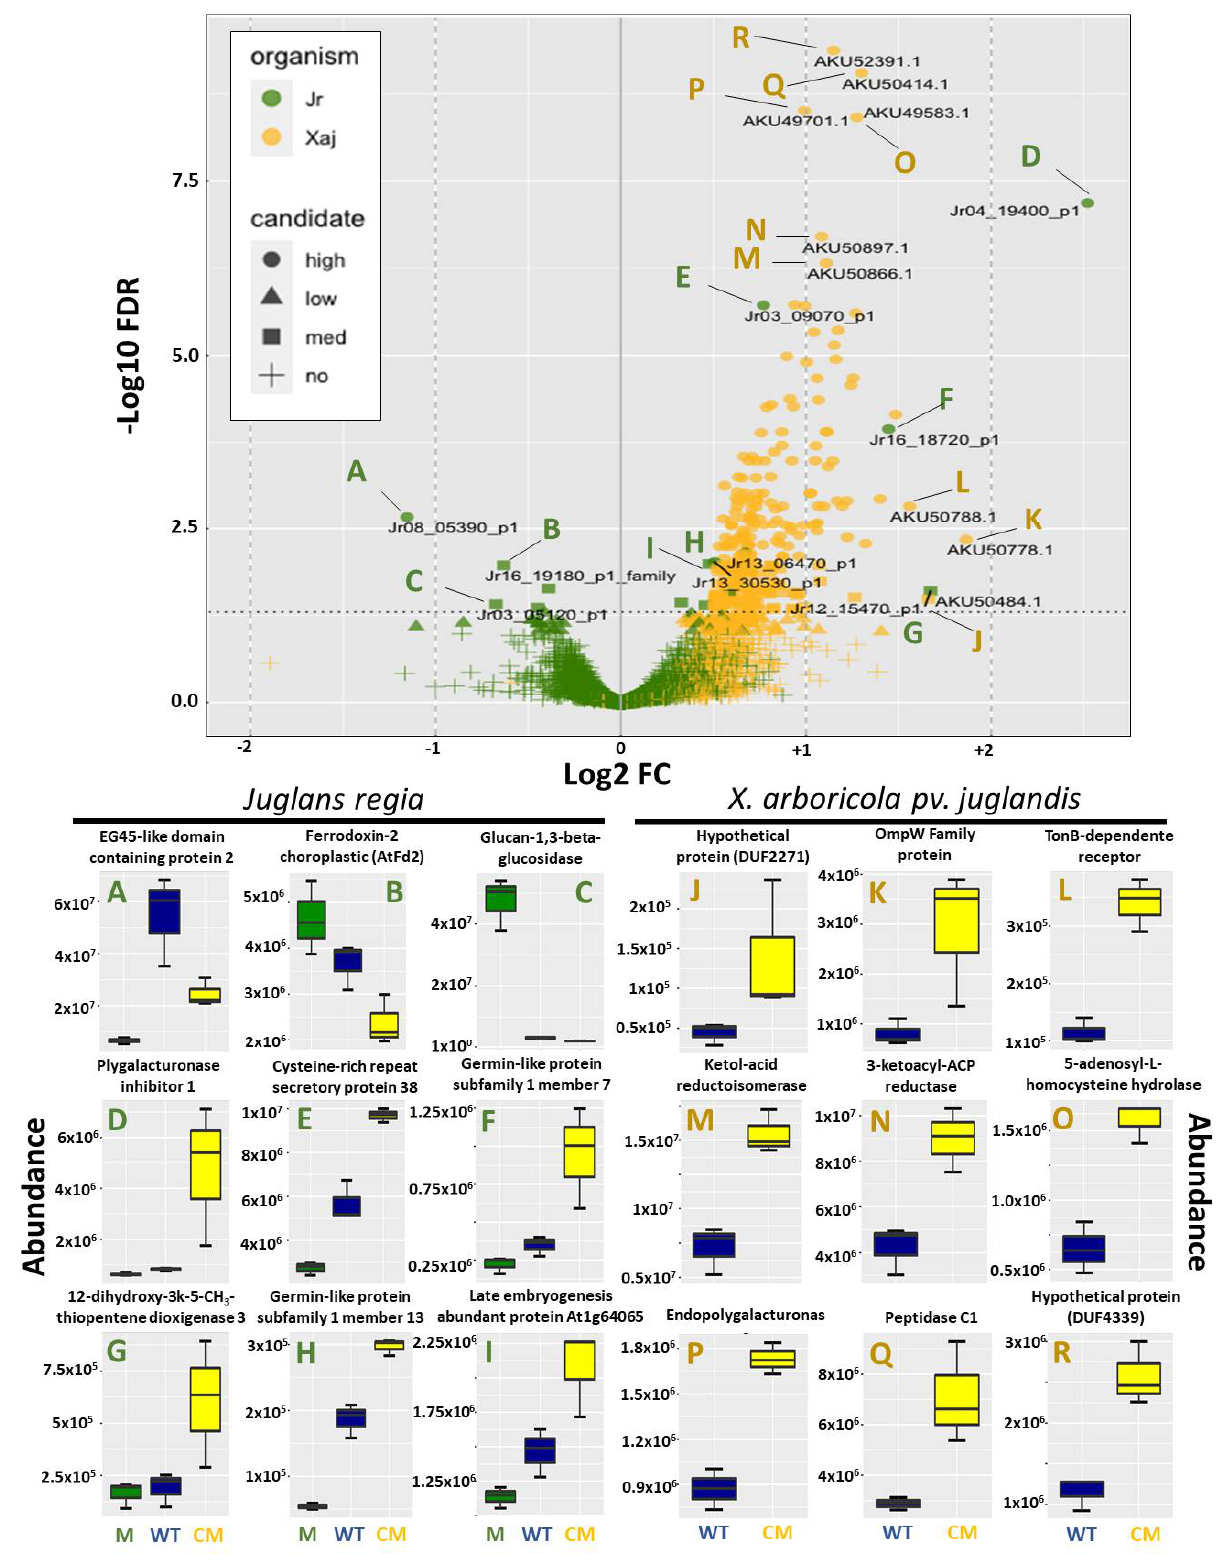
Figure 3. Volcano plot highlighting differentially abundant proteins with FDR ≤ 0.05 and protein abundance comparisons among inoculations of hull tissue with Mock ( M ), Xaj WT (WT) and XajCM (CM) of Jr ( A – I ) and Xaj ( J – R ) proteins. ( L ) TBDR AKJ12_14110.